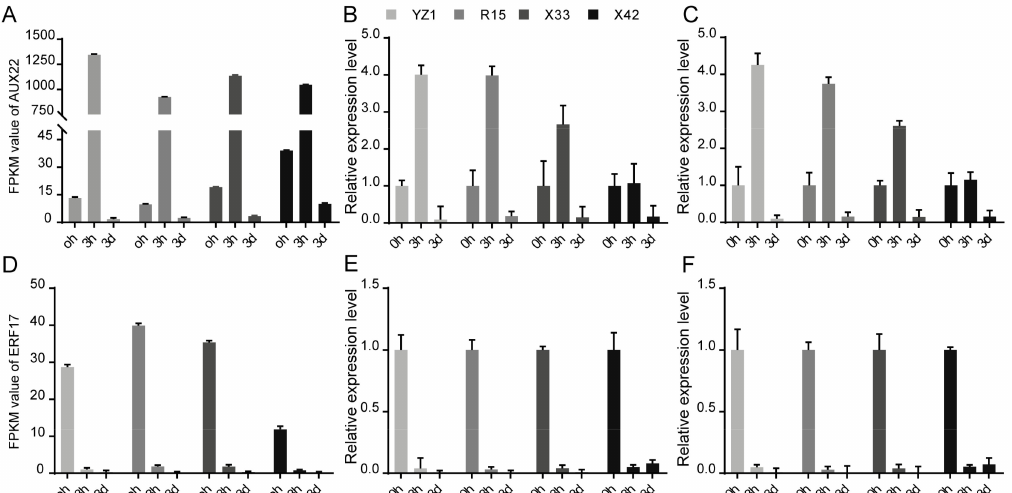
Figure5. Validationofthereferencegenesof 18SrRNA and ENDO4 asinternalcontrolsfornormalization of target gene expressions of AUX22 and ERF17 . The results were shown as mean fold changes in relative expression when compared to 0 h. ( A ) The FPKM values of AUX22 in RNA-Seq data. ( B ) The expression profiles of AUX22 normalized using 18S rRNA as an internal control. ( C ) The expression profiles of AUX22 normalized using ENDO4 as an internal control. ( D ) The FPKM values of ERF17 in RNA-Seq data. ( E ) The expression profiles of ERF17 normalized using 18S rRNA as an internal control. ( F ) The expression profiles of ERF17 normalized using ENDO4 as internal